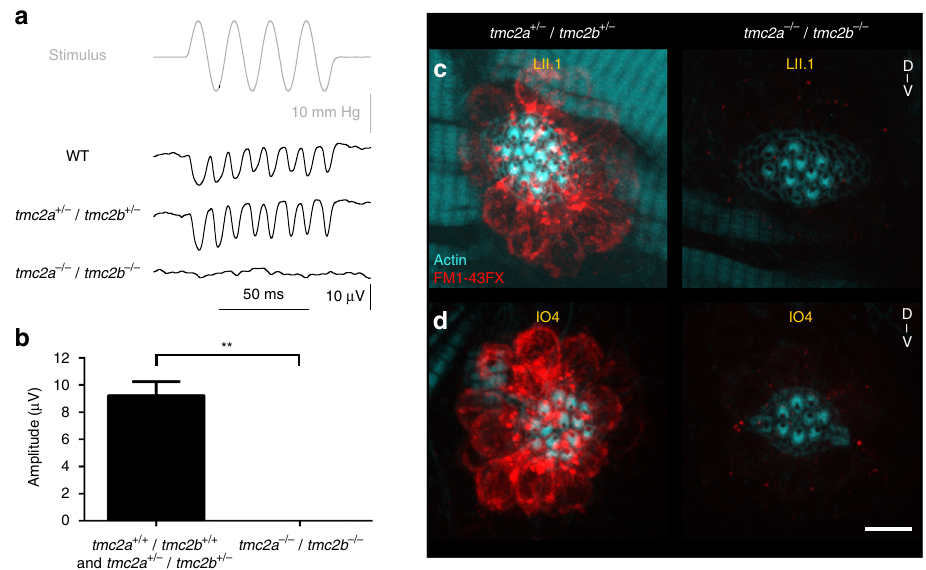
Fig. 8 Tmc2a coordinates with Tmc2b to enable mechanotransduction in lateral line hair cells. a Stimulus-evoked microphonic potentials measured from posterior neuromasts with A – P-oriented hair cells from 6-dpf zebra fi sh larvae. The response in tmc2a − / − /tmc2b − / − is absent, bottom trace. b Graph of mean microphonic potentials from posterior neuromasts with hair cells with A – P orientations ( n = 6). **Mann – Whitney test P = 0.0043. c , d Confocal images of hair cells from LII.1 and IO4 neuromasts of tmc2a + / − /tmc2b + / − or tmc2a − / − /tmc2b − / − animals labeled with FM1-43FX (red) and phalloidin (cyan). No dye was observed in LII.1 or IO4 of tmc2a − / − /tmc2b − / − animals. Scale bar = 6 μ